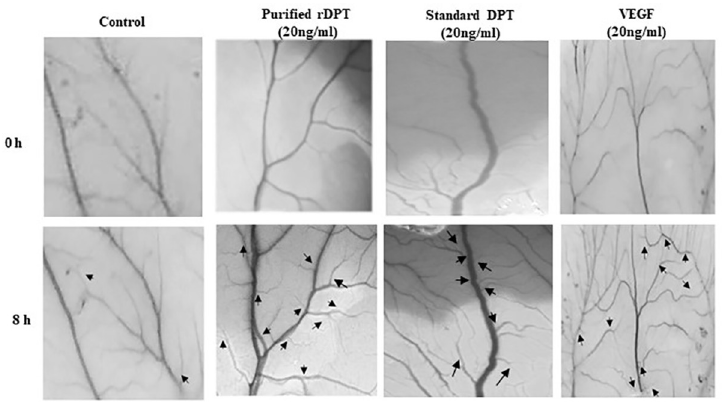
Fig 6. Angiogenesis assay using Chick Chorioallantoic Membrane (CAM) model. Photographic images of CAM taken at 0 h and 8 h after treatment with equal concentrations (20ng/ml) of purified recombinant Dermatopontin, standard Dermatopontin and Vascular Endothelial Growth Factor. Arrows denote the newly formed capillaries.